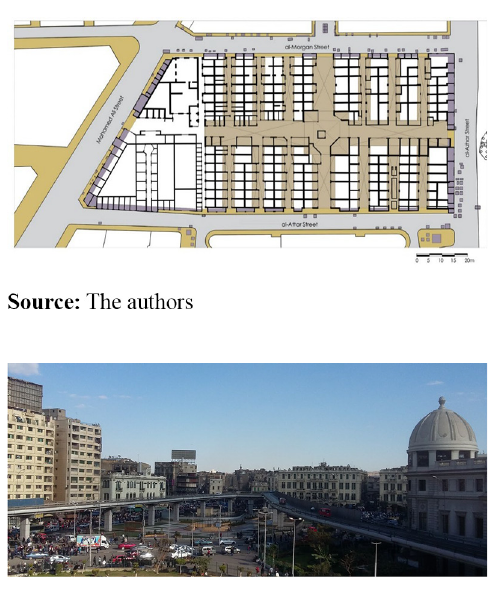
Figure 5. Al-Azhar fl yover over Attaba